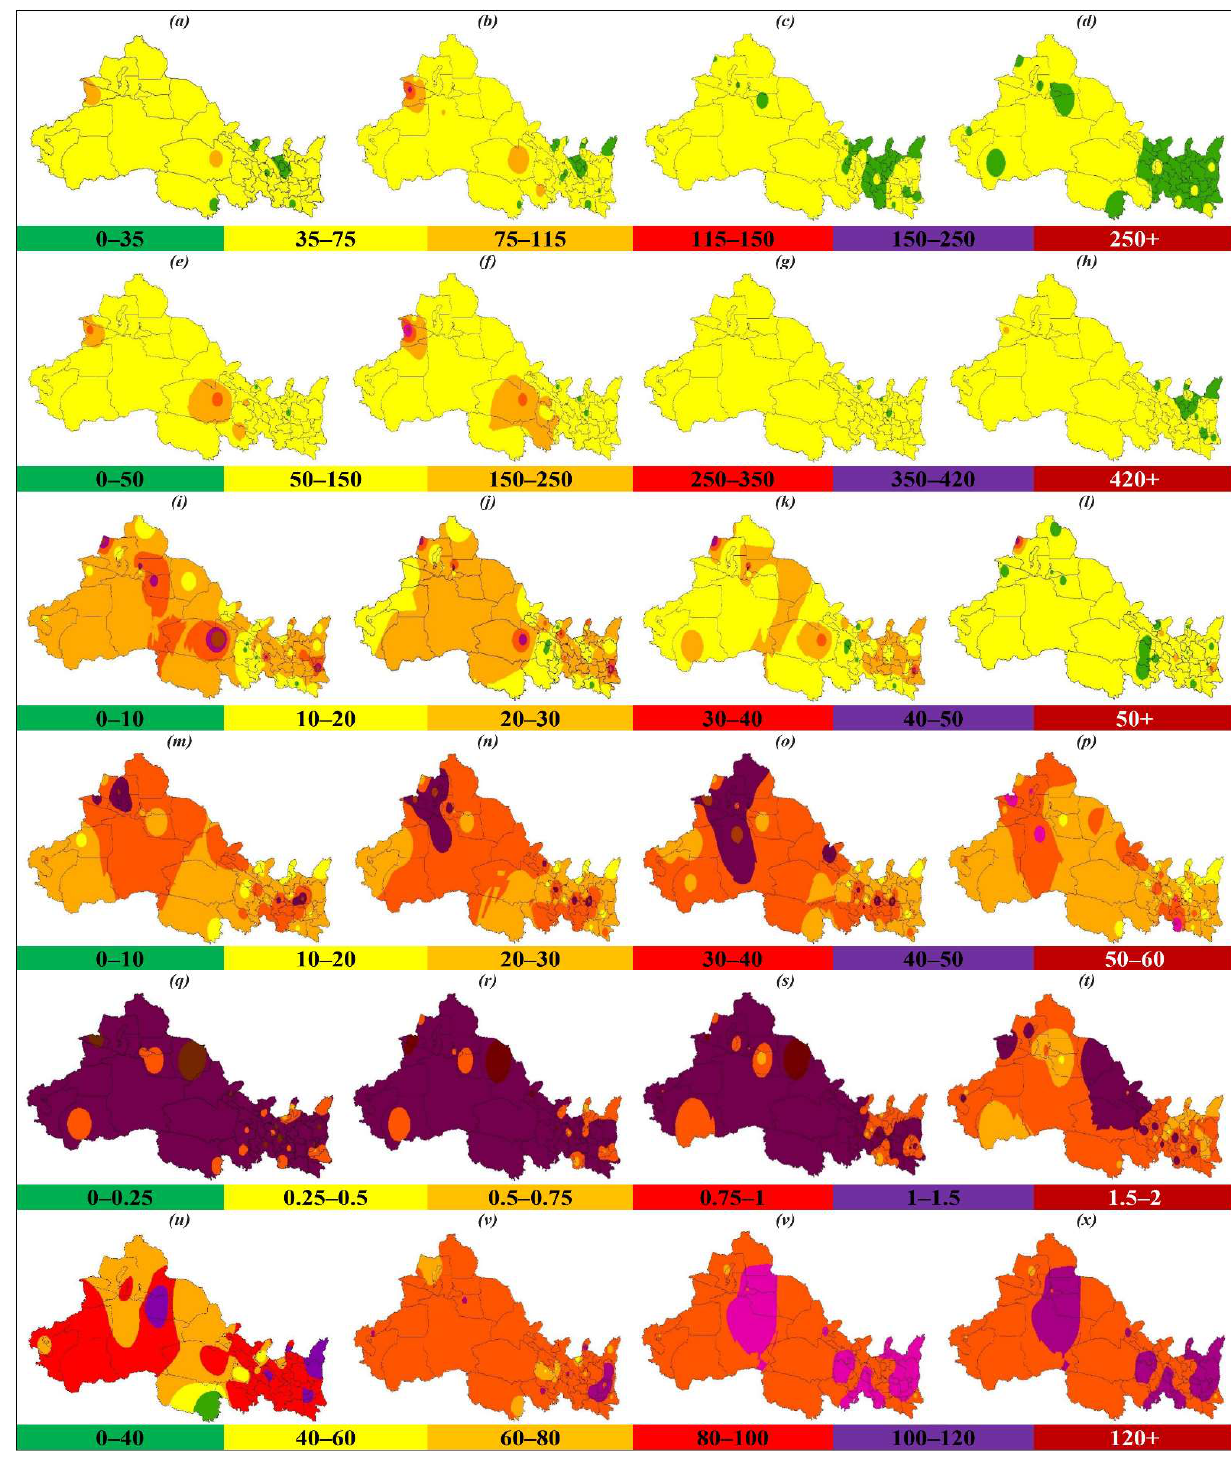
Figure 2. The spatial distribution of PM 2.5 ( a – d ), PM10 ( e – h ), SO 2 ( i – l ), NO 2 ( m – p ), CO ( q – t ), and O 3 ( u – x ) between 2015 and 2018 in northwest China (NWC). Color represents the different pollution levels, e.g., green (good), yellow (moderate), orange (unhealthy for the sensitive group), red (unhealthy for all), purple (very unhealthy), and maroon (hazardous). The abbreviations are as follows: PM 2.5 (fine particulate matter), PM 10 (coarse particulate matter), SO 2 (sulfur dioxide), NO 2 (nitrogen dioxide), CO (carbon monoxide), and O 3 (ozone).